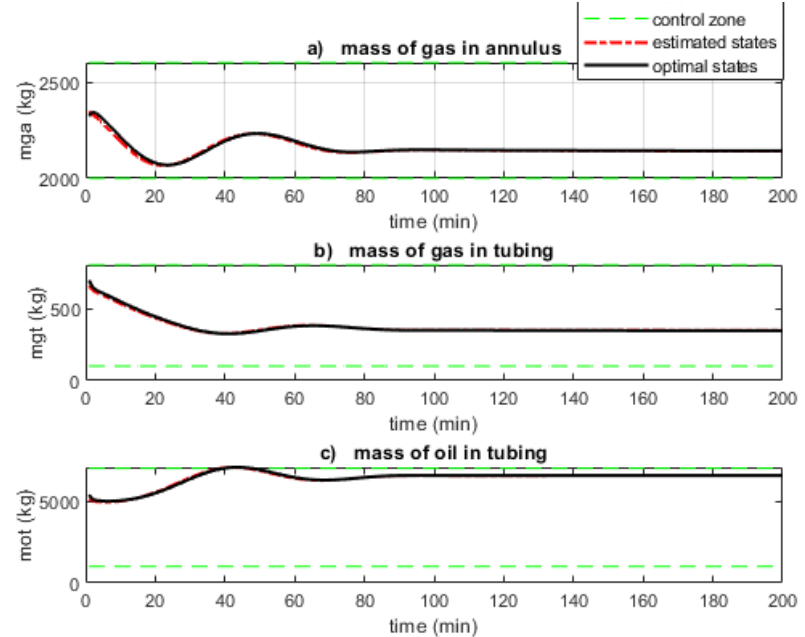
Figure 7. Optimal and estimated states of the gas-lifted system. The optimal states are the true states of the system, while the estimated states are the EKF outputs. The states are within the state zones, and the states are stabilised by NMPC despite the input target falling within the unstable